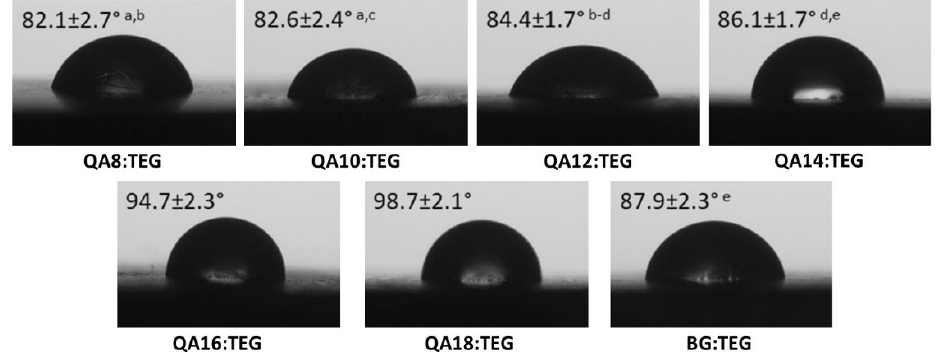
Figure 5. The images of deionized water droplets on the studied copolymer surfaces obtained from the goniometry camera. Lower case letters indicate statistically insignificant differences ( p > 0.05) (non-parametric Wilcoxon test).